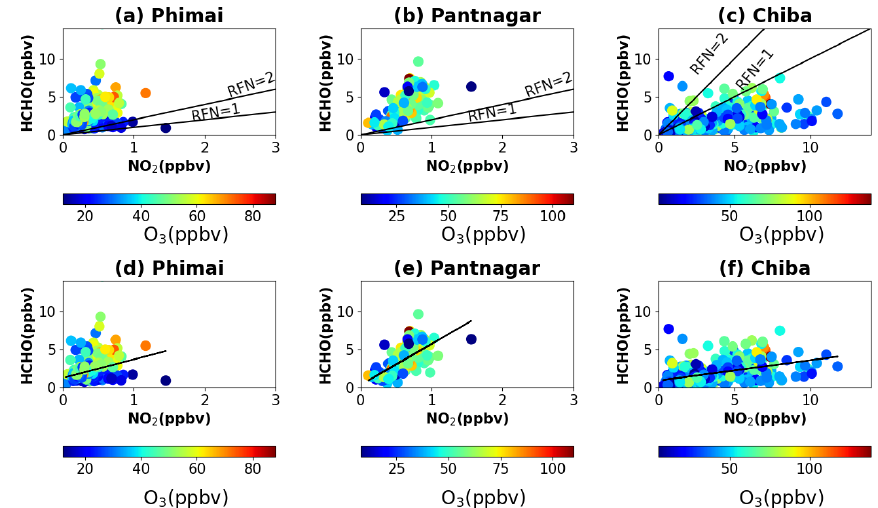
Figure 5. Scatterplots of HCHO and NO 2 concentrations in the 0–2km layer at (a, d) Phimai, (b, e) Pantnagar, and (c, f) Chiba, colored with the O 3 concentrations in the 0–2km layer at the respective sites. The solid lines in panels (a) – (c) represent R FN = 2 and R FN = 1 benchmarks. The black lines in panels (d) – (f) are calculated according to Eq.